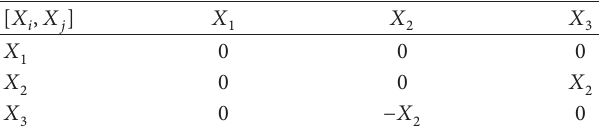
Table 1: The commutator table of the approximate symmetries of the KPP